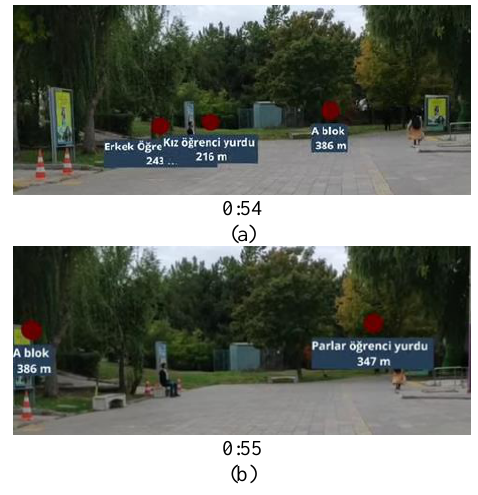
Figure 8. The POI labelled as ‘A blok’ moves substantially in less than a second in two consecutive frames (0:54 –